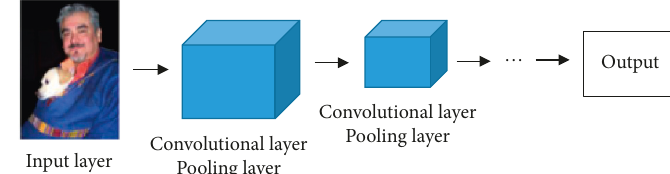
Figure 2: Convolutional neural network architecture.